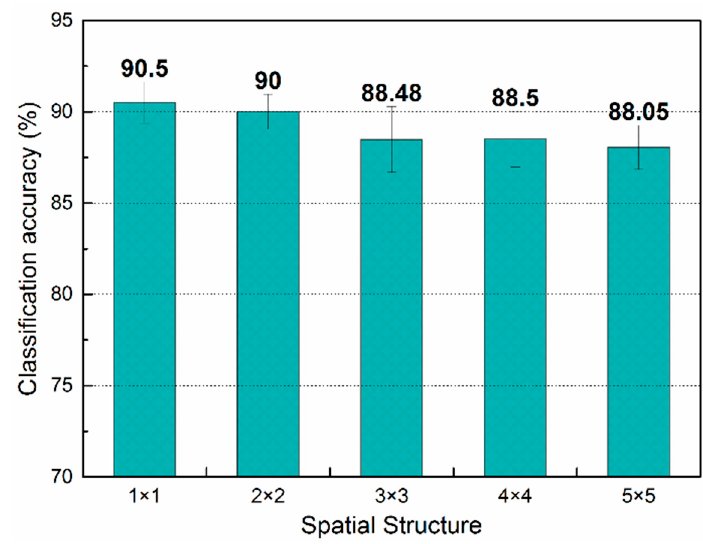
Figure 10. Classification performance of different spatial structures for HCV on the LU database.